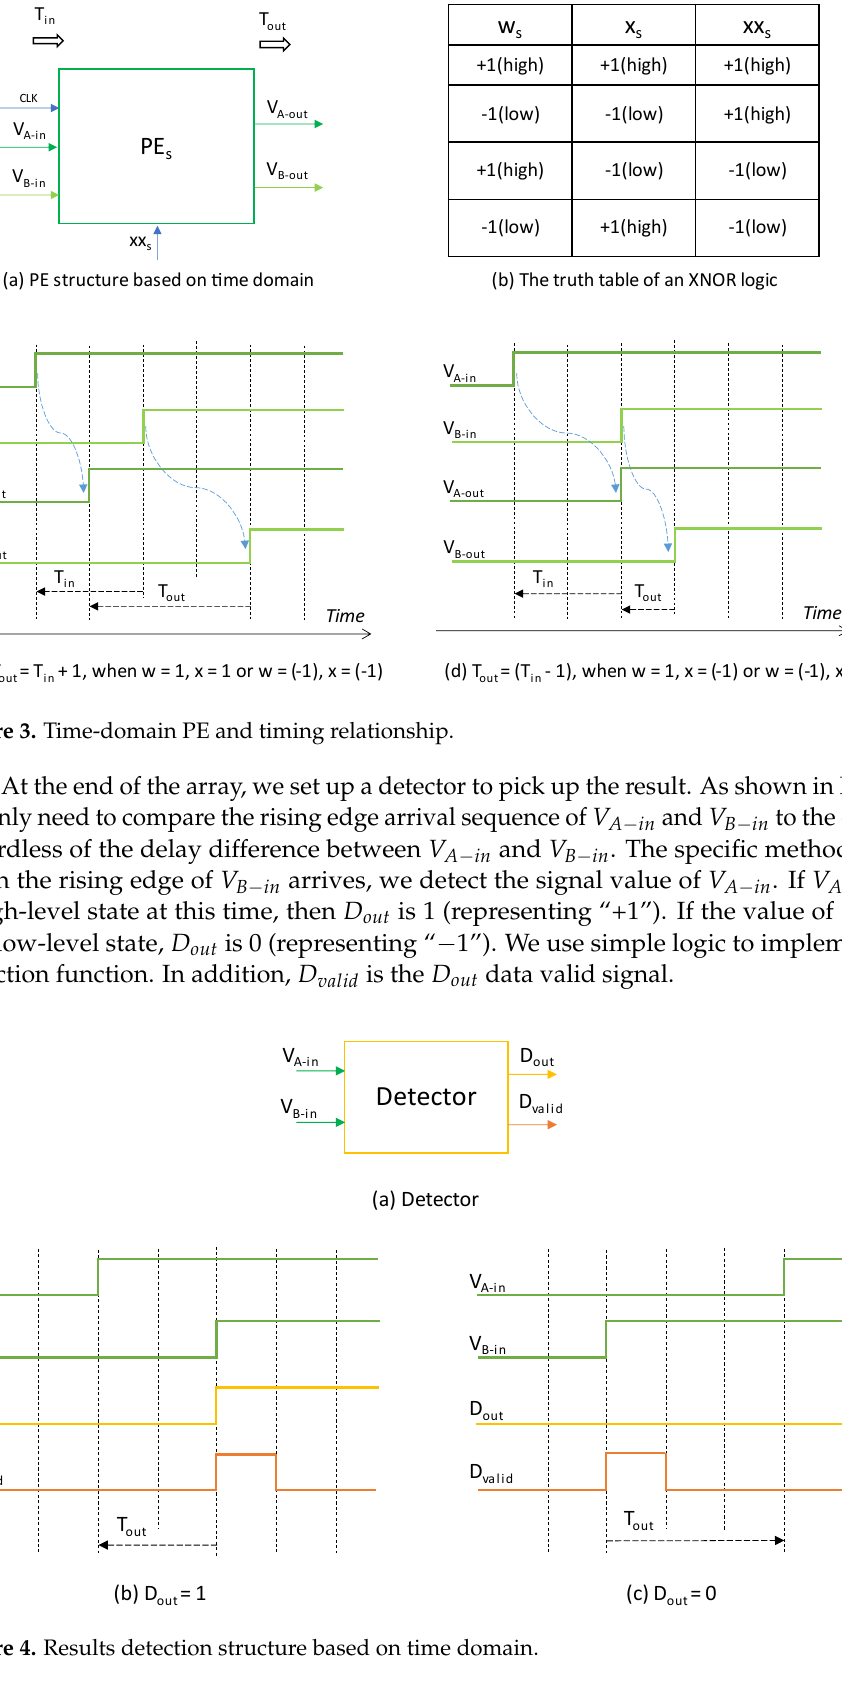
Figure 4. Results detection structure based on time domain.